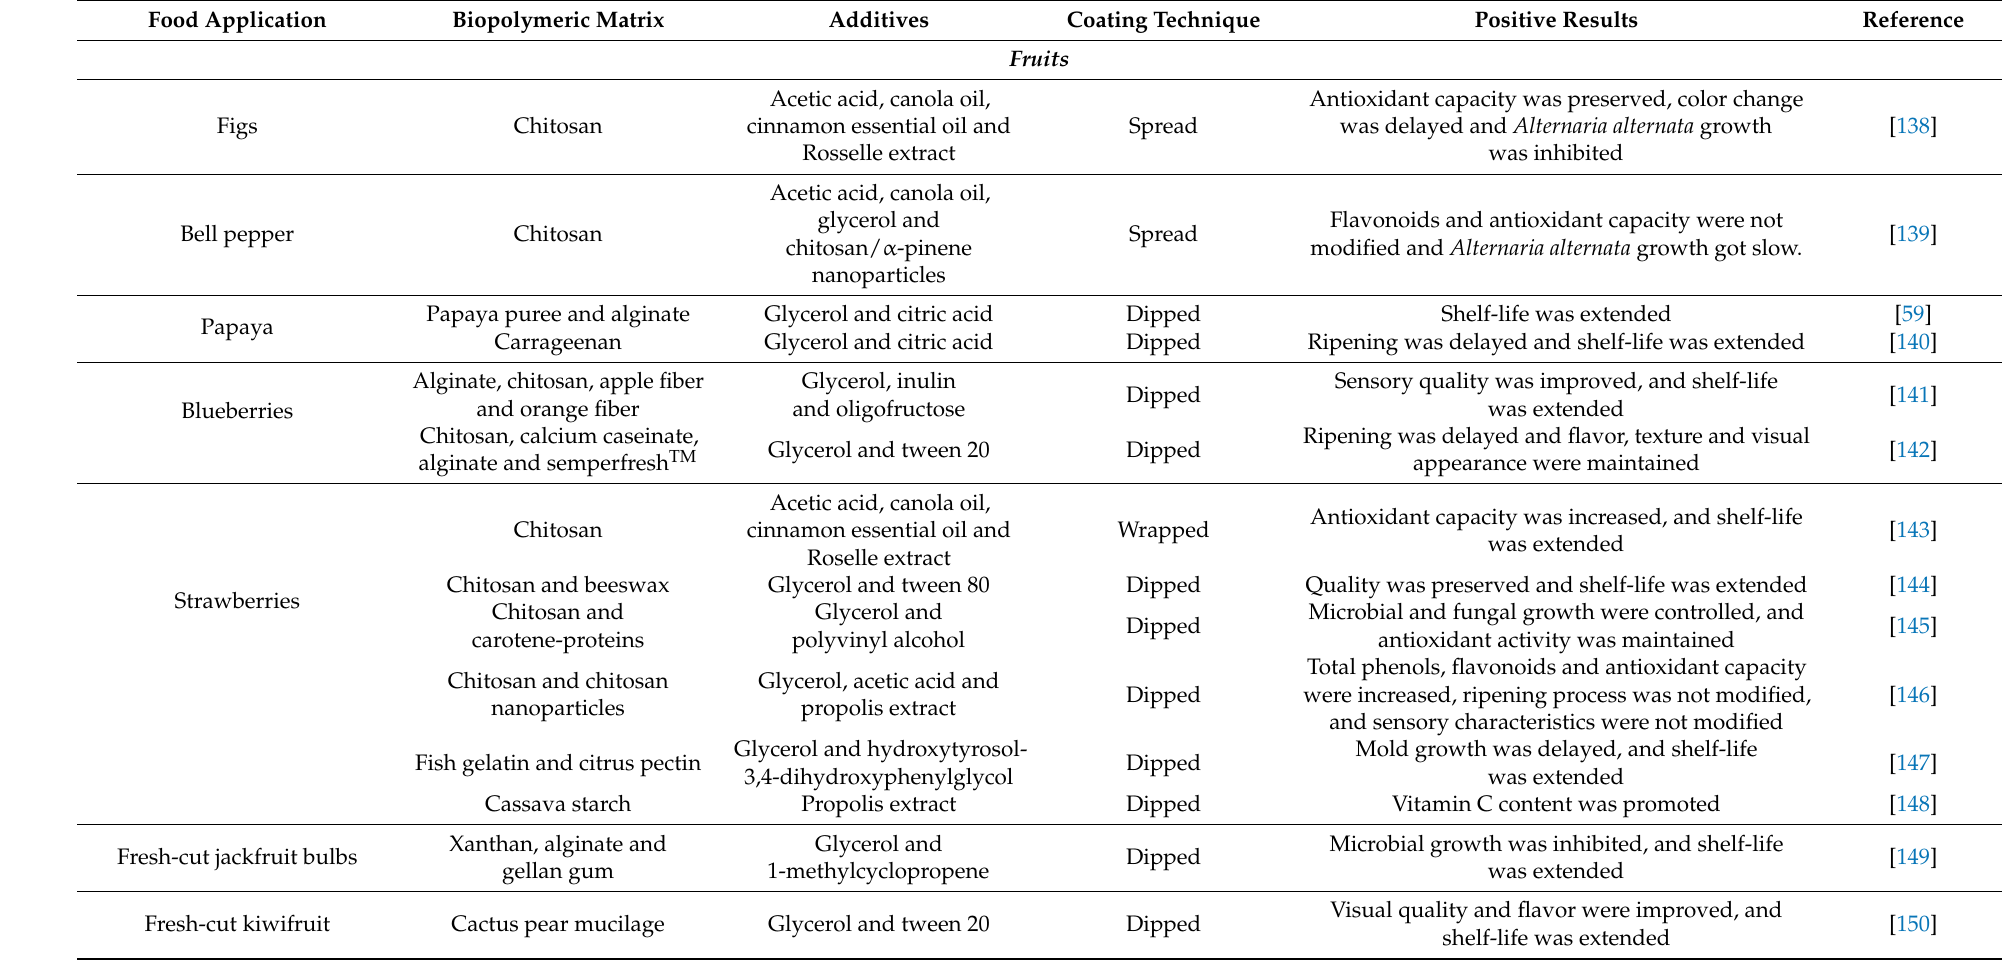
Table 6. Edible films and coatings applied in food